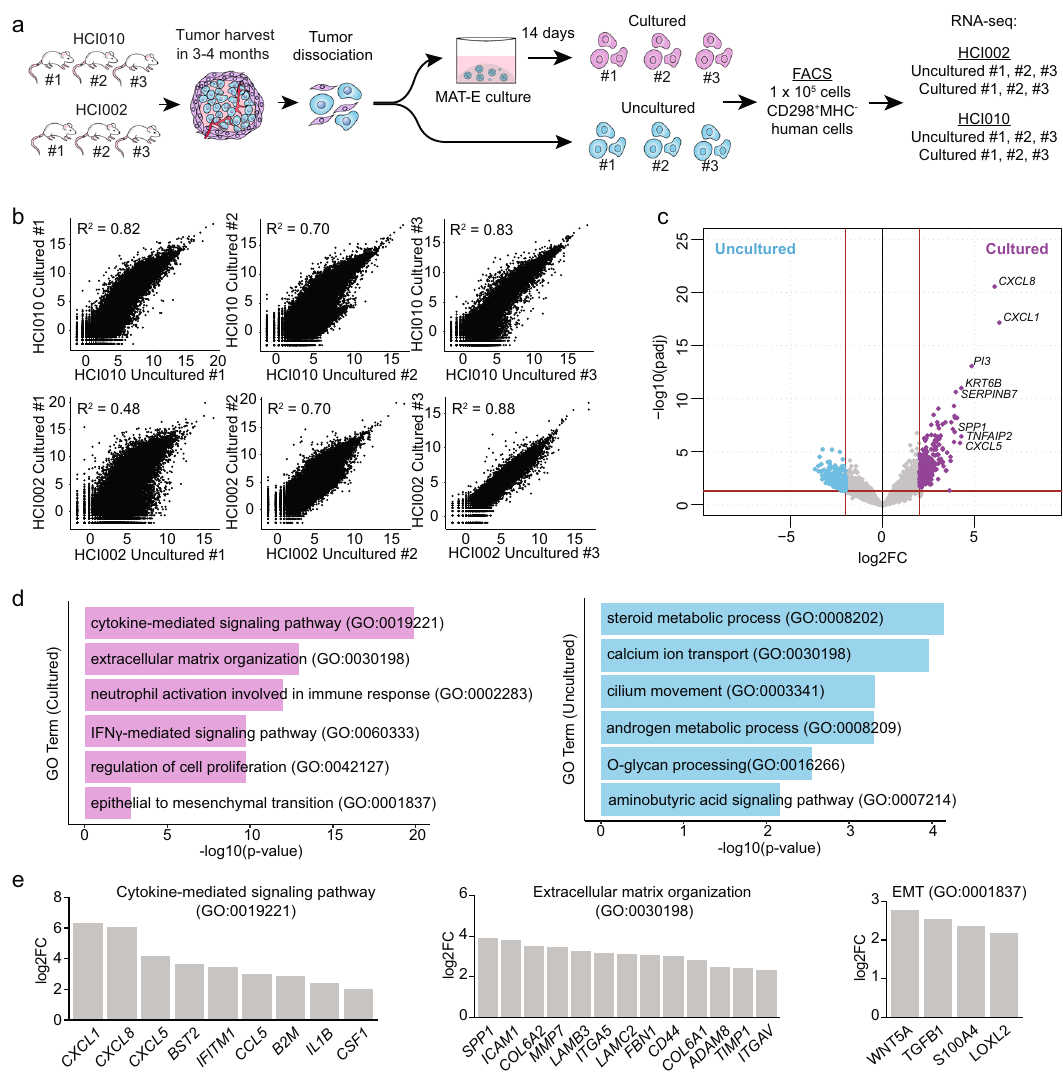
Fig. 2 PDX tumor sphere cells maintain their global transcriptome program. a Work fl ow schematic for generation of RNA-seq data set to compare transcriptome signatures in paired cultured and uncultured cells from HCI002 and HCI010. b Scatter plots show the correlation of gene expression across the entire transcriptome in paired cultured and uncultured samples ( n = 22,446 genes). Pearson ’ s correlation coef fi cient ( R 2 ) is shown for each pair. c Volcano plot shows genes signi fi cantly upregulated in cultured ( n = 277 genes) or uncultured ( n = 1455 genes) cells that are conserved in all pairs (log2FC > 2, adj p < 0.05). See Supplementary Data 1 for the full gene list. FC = Fold change. Adjusted P value determined in DESeq2 by Benjamini – Hochberg adjustment of Wald test P alues. d Bar graph shows GO terms associated with genes upregulated in cultured ( n = 277 genes) and uncultured ( n = 1455 genes) cells (log2FC > 2, adj p < 0.05). P value determined using Enrichr by Fisher ’ s exact test. e Bar graphs show select GO term- associated genes upregulated in cultured cells. See Supplementary Data 1 for the full gene list. FC = Fold change. P value determined by Wald